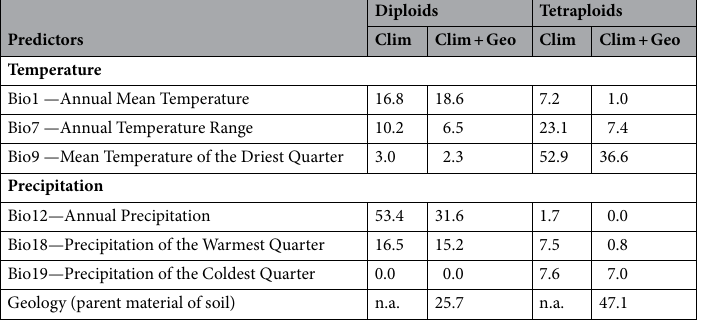
Table 1. Percentage contribution of predictors used in Maxent niche modelling in diploids and tetraploids of Festuca amethystina . Models with two sets of predictors were used and compared in the analysis: only climatic and climatic + geology (parent material of soil)